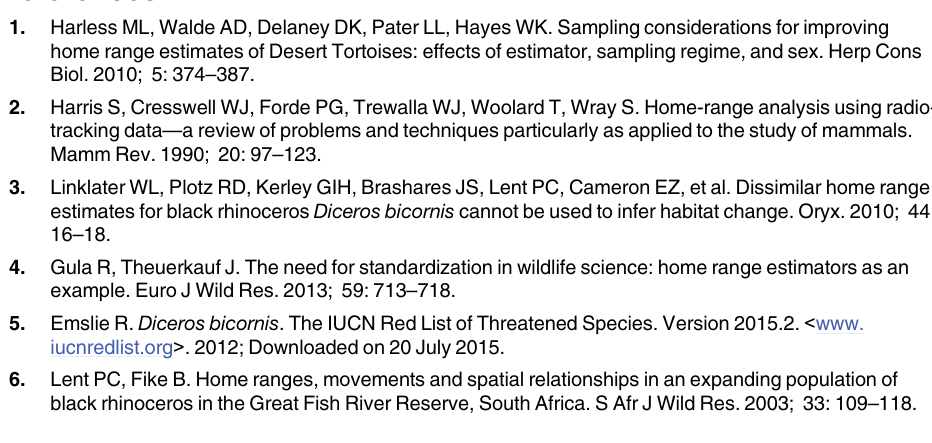
S1 Table. Detailed comparison of methodology of black rhinoceros home range studies outside of Hluhluwe-iMfolozi Park. Note that this table excludes home range studies in unpublished material e.g., Rhino Management Group (RMG) reports. The RMG reports are not publicly available, but several reports seen by the authors list average home range sizes for most black rhino populations across Africa without reference to the methodology or the home range studies used to calculate them. (cid:3) The average duration (time-period) between locations per